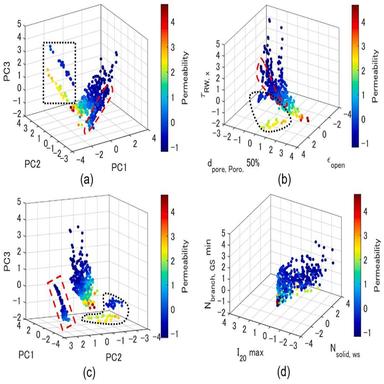
Visualization of the descriptor spaces: (a) selected, (b) conventional, (c) FS, and (d) low-rank sets. The plots are colored according to the values of the permeability. The values of the PCs, descriptors, and permeability are standardized.